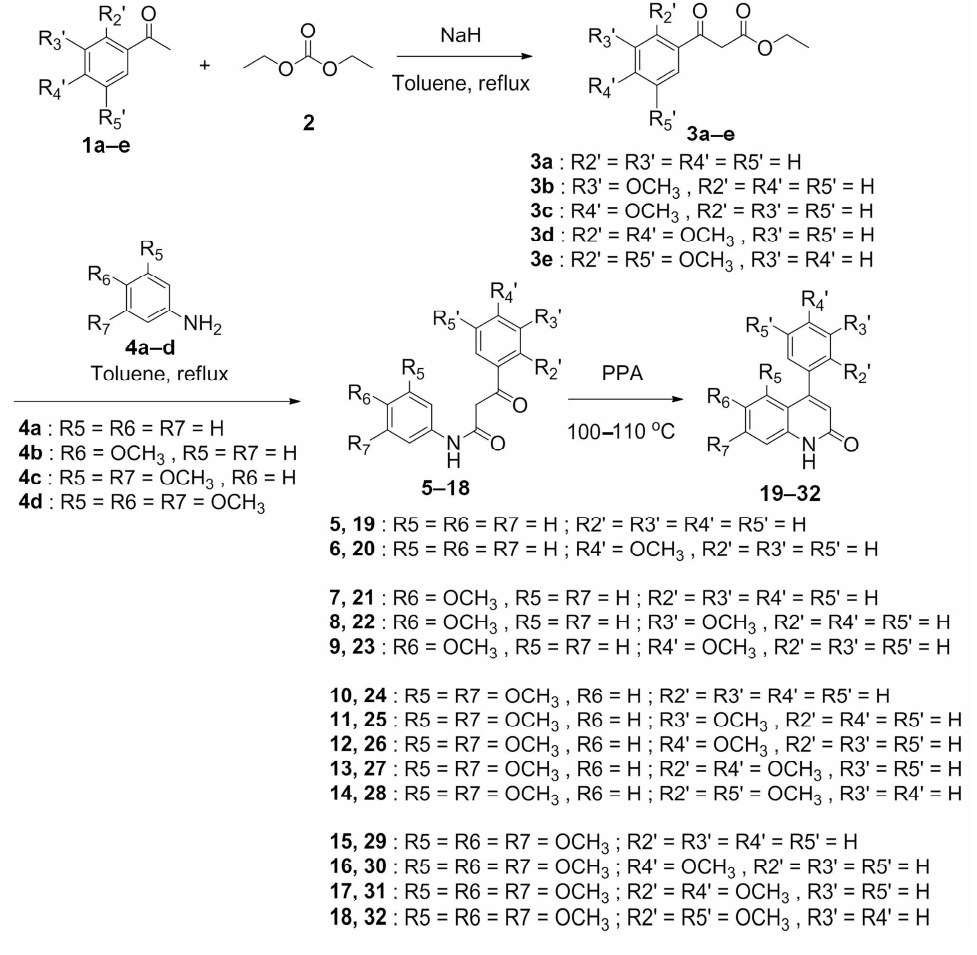
Scheme 1. The synthesis route of 4-phenylquinolin-2(1 H )-one (4-PQ)